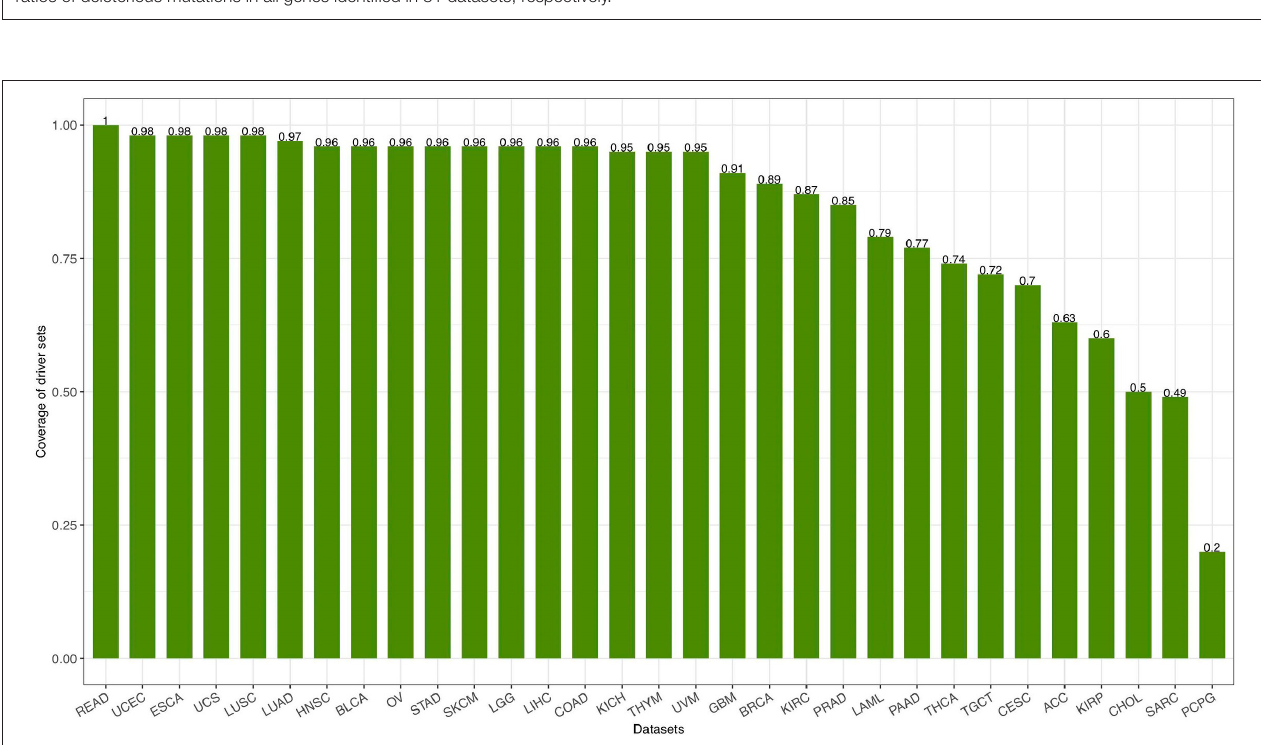
FIGURE 7 | The coverage of driver gene sets identified by functional impact prediction neural network (FI-net) in the 31 datasets.